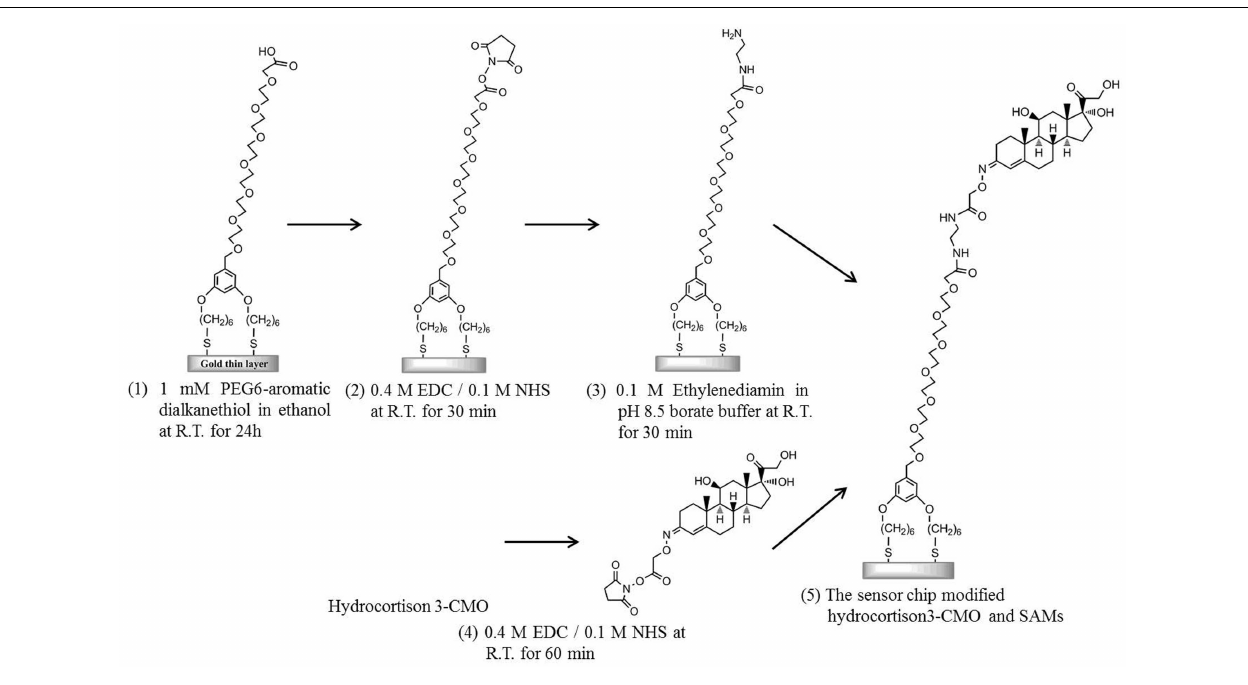
FIGURE 1 | Fabrication procedure of the sensor chip modified with cortisol analog